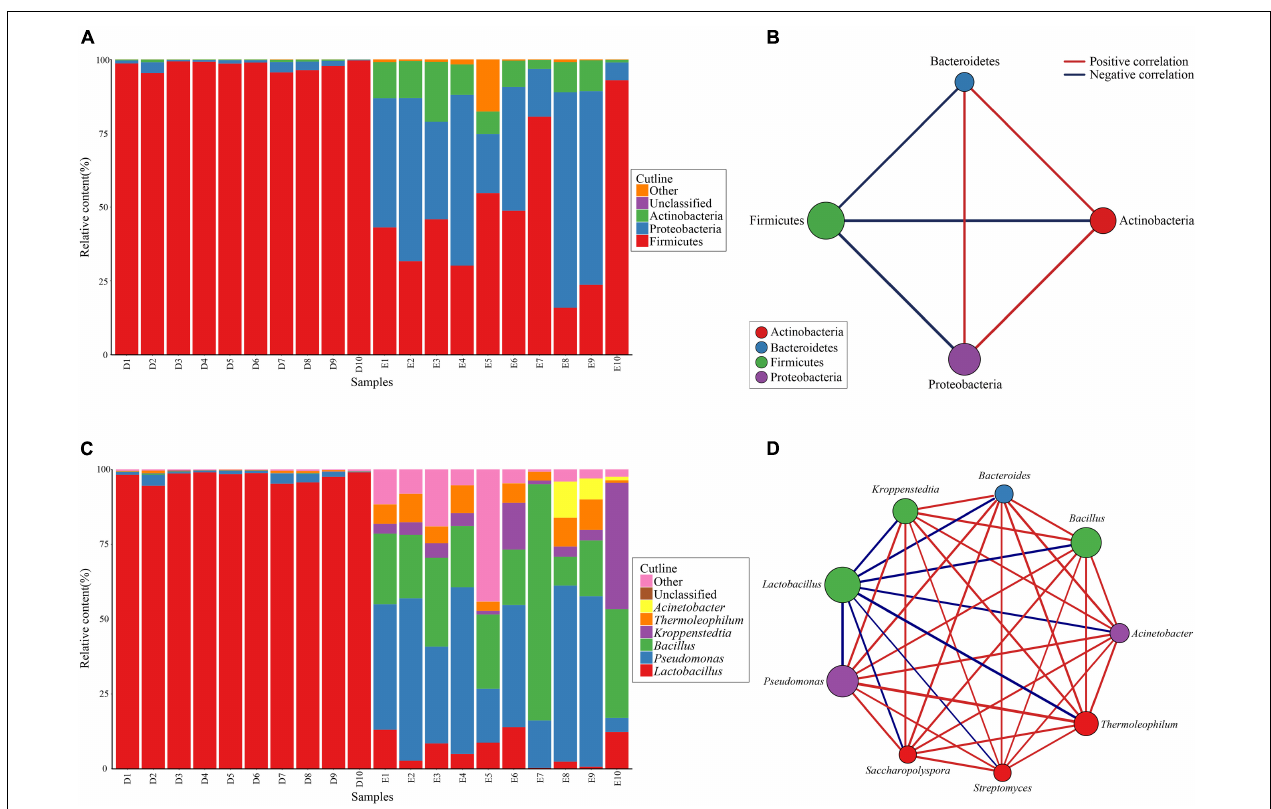
FIGURE 3 | Composition and correlation of bacterial phyla (A,B) and genera (C,D) with relative content more than